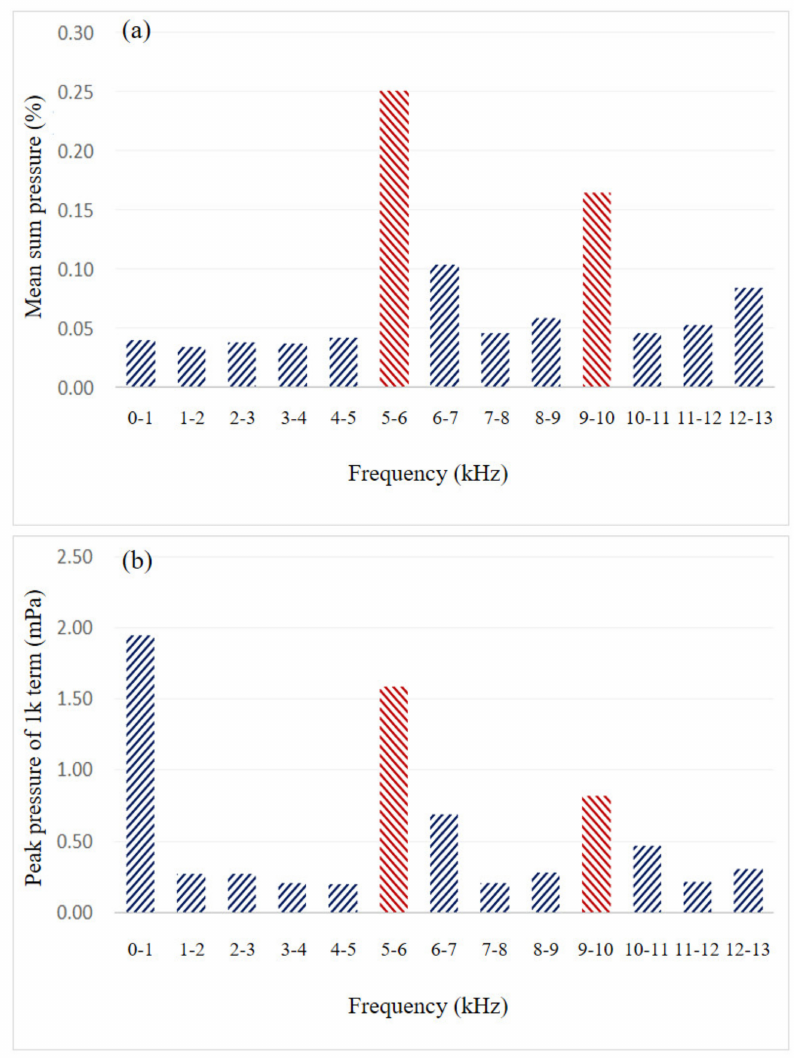
Figure 14. Sound pressure in 1-kHz increments with 12.70-mm particles. ( a ) Mean sum; ( b ) peak